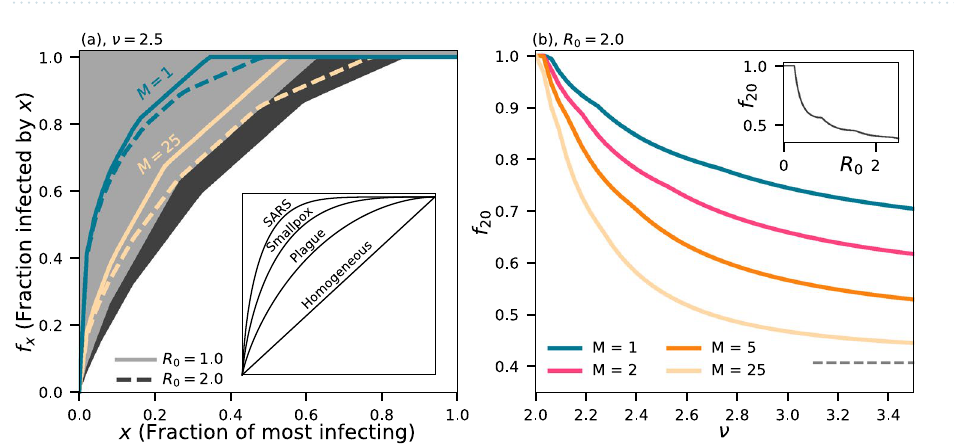
Figure 4. Spreading statistics. ( a ) The fraction f x of people infected by the x most infectious people. Dark background indicates limit set by Poisson statistics alone. Colored indicate M as in ( b ), and full lines are for 1.0 and dashed for R 0 2.0 . Inset adapted from Ref. 2 showing estimated graphs for select historical R 0 = = epidemics. ( b ) The fraction of people f 20 that the most infectious 20% will infect for R 0 ν . Inset shows f 20 in the simple case of pure Poisson statistics as a function of R 0 . Dashed line in main plot 2.0 indicates the Poisson value for R 0 =